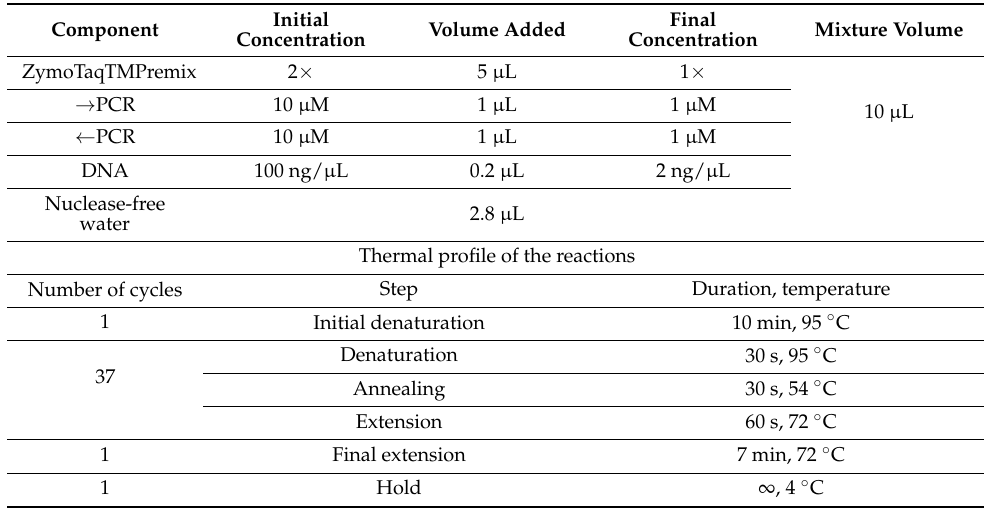
Table 2. PCR mixture content and thermal profile of the